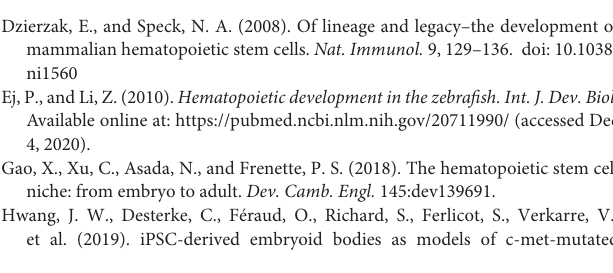
Supplementary Figure 1 | Canonical correlation with batch correction between the two fetal kidneys process in single cell transcriptome. (A) Factorial map showing superposition of the cells from the respective kidneys. During normalization of the transcriptome, a canonical correlation normalization was applied between the cells of the 2 kidneys, the factorial map showed that cells from each kidney were well spread on this map with a good overlapping. (B) Profile of the shared correlation strength between the respective kidneys (30 dimensions); tSNE plot post canonical correlation on the merged 2 kidneys. (C) t-SNE dimension reduction of single cell transcriptome from human fetal kidney after batch correction, cells from each kidney (respectively green and red) are plotted with t-SNE dimension reduction algorithm and their distribution in the map confirmed a good batch correction during the analyses (canonical correlation with Seurat